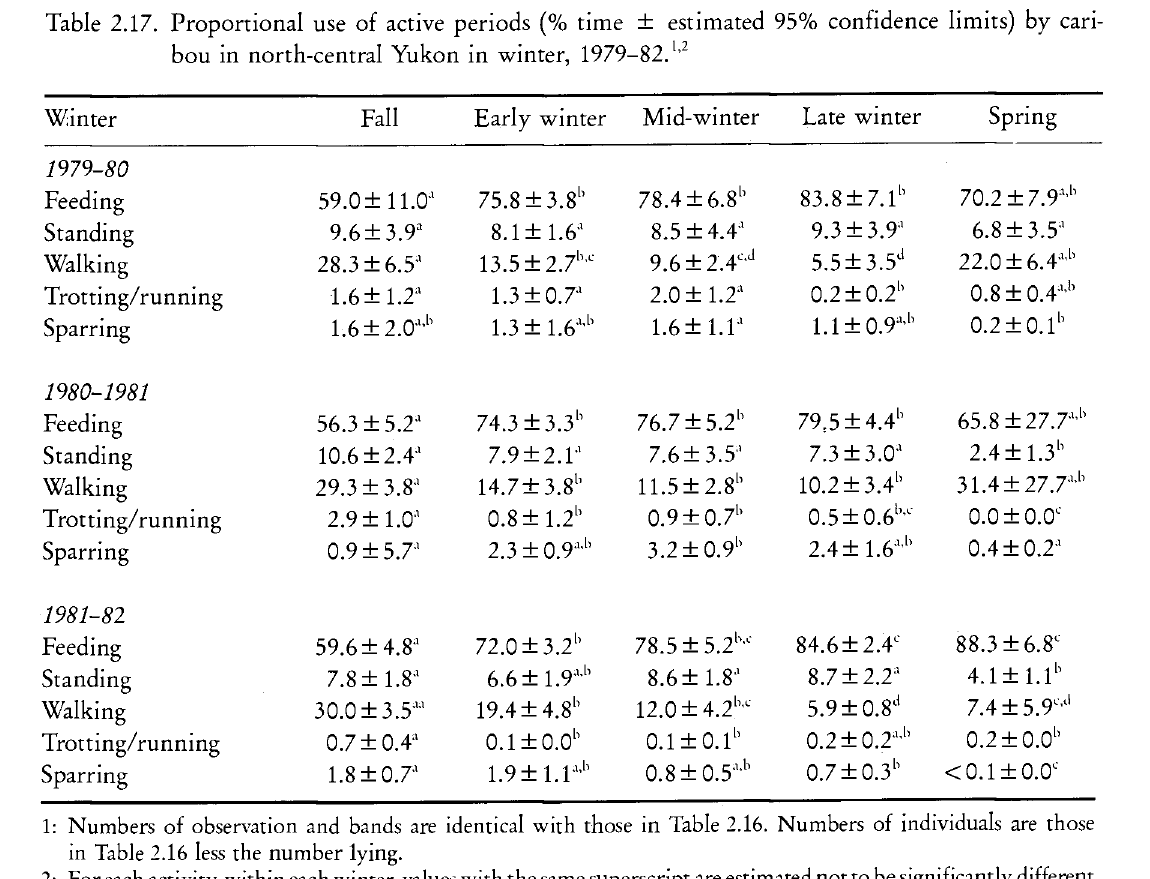
Table 2.17. Proportional use of active periods (% time ± estimated 95% confidence limits) by cari bou in north-central Yukon in winter, 1979—82. 1 '